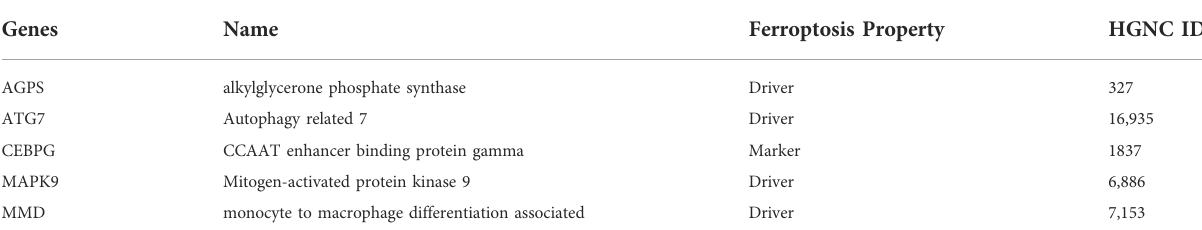
TABLE 3 The information of 10 prognostic genes.